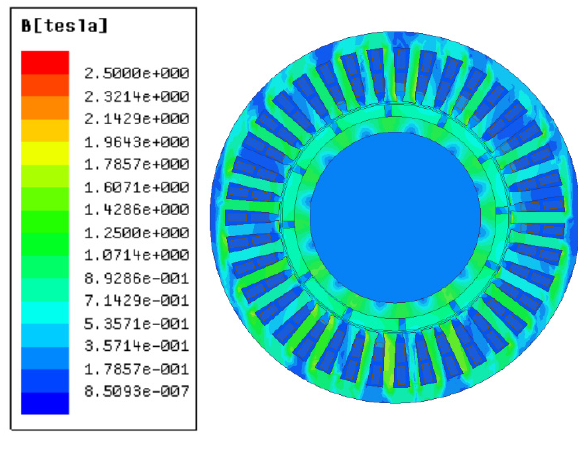
Figure 3. 2-D flux density distribution of the BLDCM.